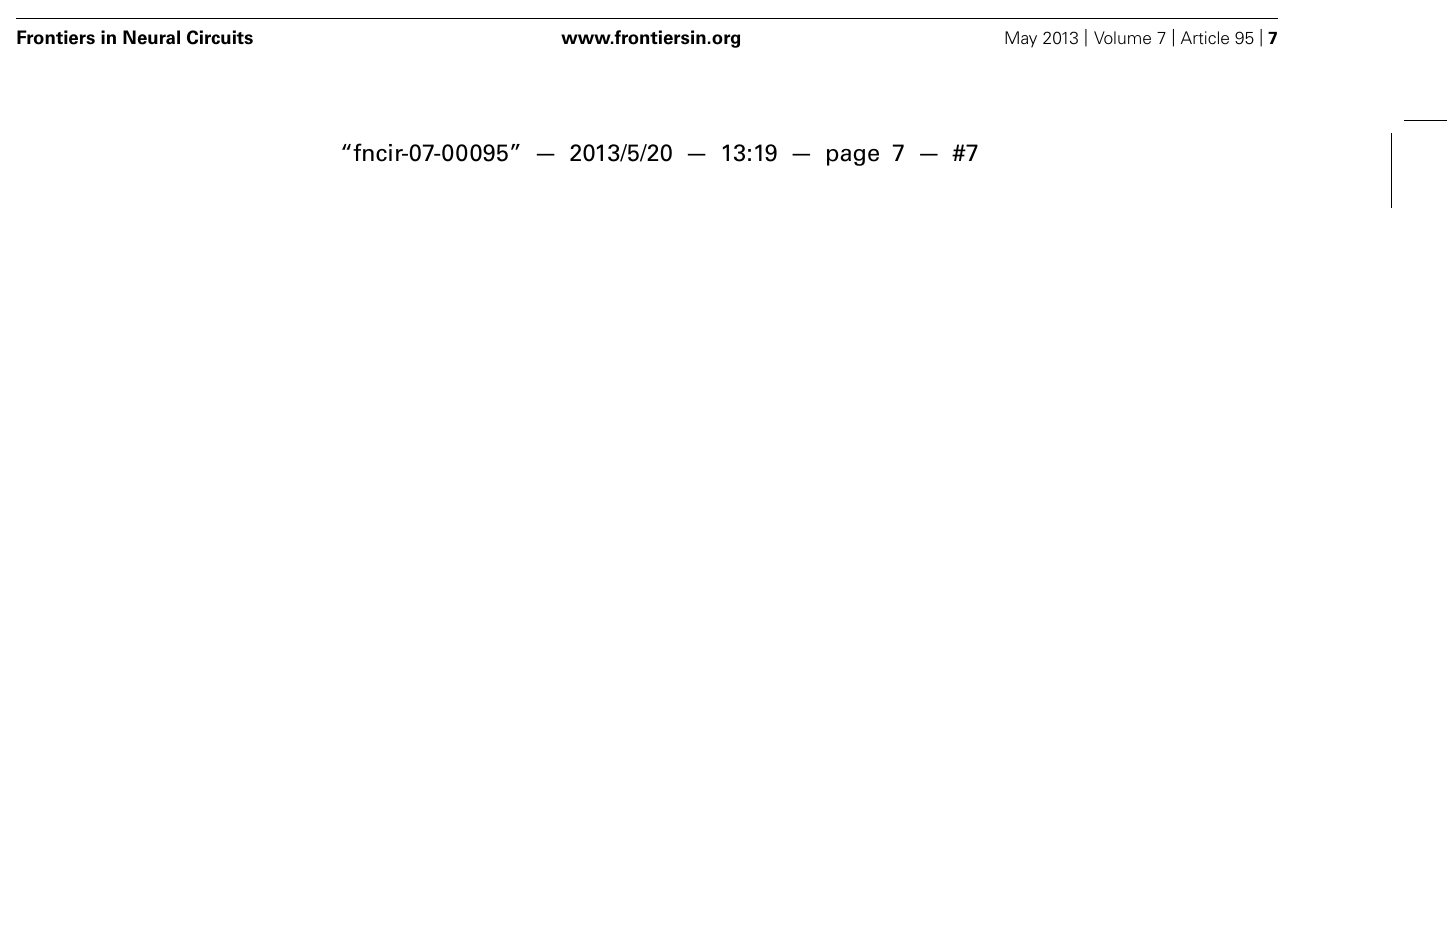
FIGURE 3 | Slopes of nearly perfect linear correlations between charge and burst length reveal limited signaling for frequencies higher than 300 Hz as a result of insufficient glutamate release. (A) Correlations between relative charge and burst length at 100, 300, 500, and 700 Hz; no differences were seen in the slopes between 300, 500, and 700 Hz ( p > 0.05; n = 6). (B) Similar experiment as shown in A repeated in current clamp. Recording conditions had no effect on the outcome ( n = 6). (C) Similar experiment as shown in A, now including 200 Hz. Note that the slope measured for 200 Hz differed significantly from that at 100, 300, and 500 Hz ( p < 0.05; n = 8). (D) When CX546 was applied, correlations were less linear